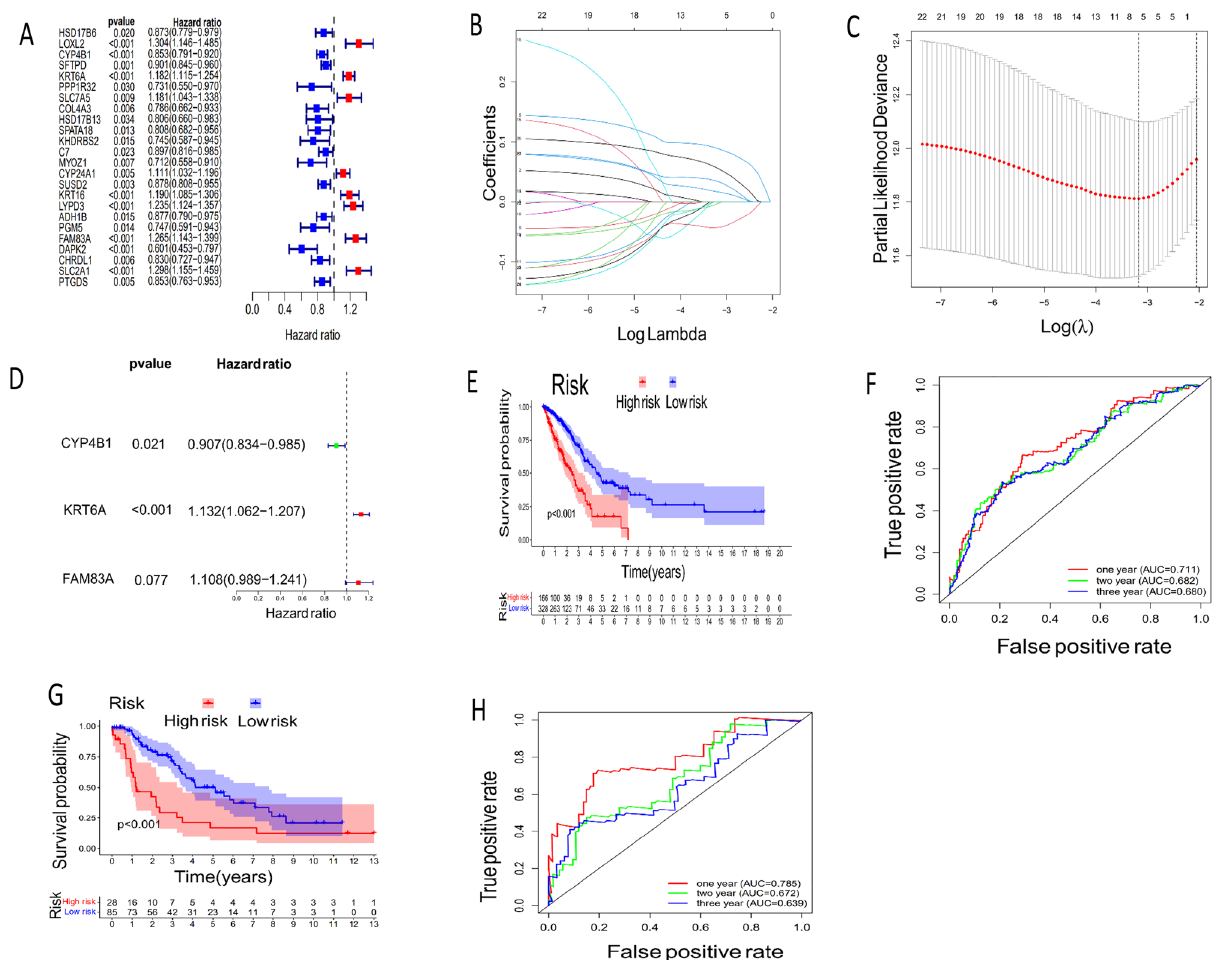
Figure 2. Establish and verify the early diagnosis and prognosis model. ( A ) Univariate Cox survival analysis was performed for the early diagnosis genes. ( B ) A 1000-fold cross-validation for tuning parameter selection in the least absolute shrinkage and selection operator (LASSO) model. ( C ) LASSO coefficient profiles of the 24 early diagnosis and prognosis-related genes. ( D ) Multivariate Cox regression of three risk genes. E, G, KM survival analysis was performed to determine survival differences between different analysis groups, from TCGA and GEO ( G ) data sets. ( F , H ) The ROC curve revealed the AUC value of the prognostic model in the TCGA ( F ) and GEO ( H )